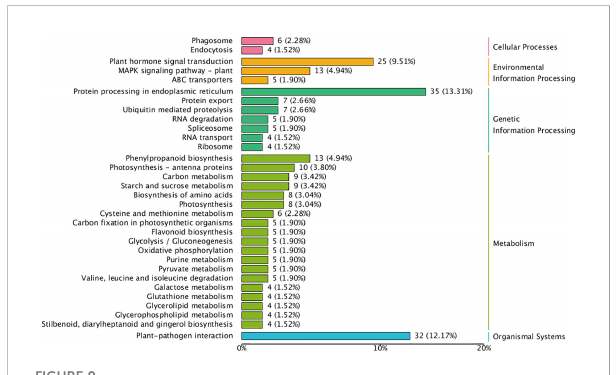
FIGURE 9 Pathway enrichment for target genes of signi fi cant difference